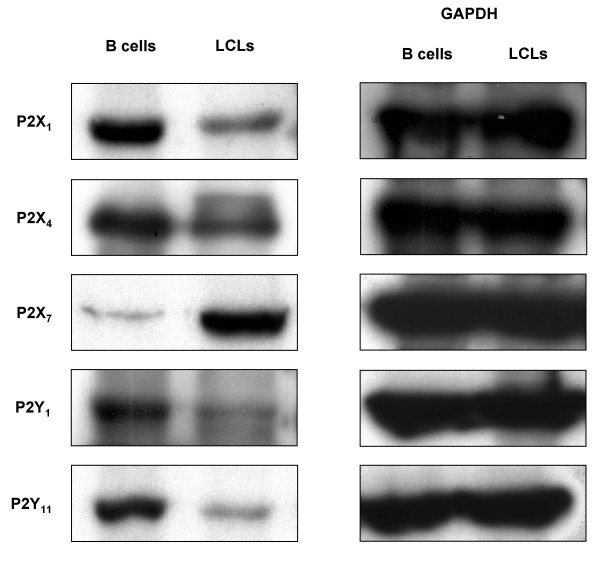
P2 receptors (P2X1, P2X4, P2X7, P2Y1, and P2Y11) compared by Western blotting in B cells and LCLs. Proteins extracted from B cells and LCLs were probed with rabbit polyclonal antibodies directed against P2X1 (60-kDa), P2X4 (65-kDa), P2X7 (68-kDa), P2Y1 (66-kDa), and P2Y11 (50-kDa) (left). Membranes were re-probed by GAPDH (40-kDa) (right). Data are representatives of 4 independent experiments.